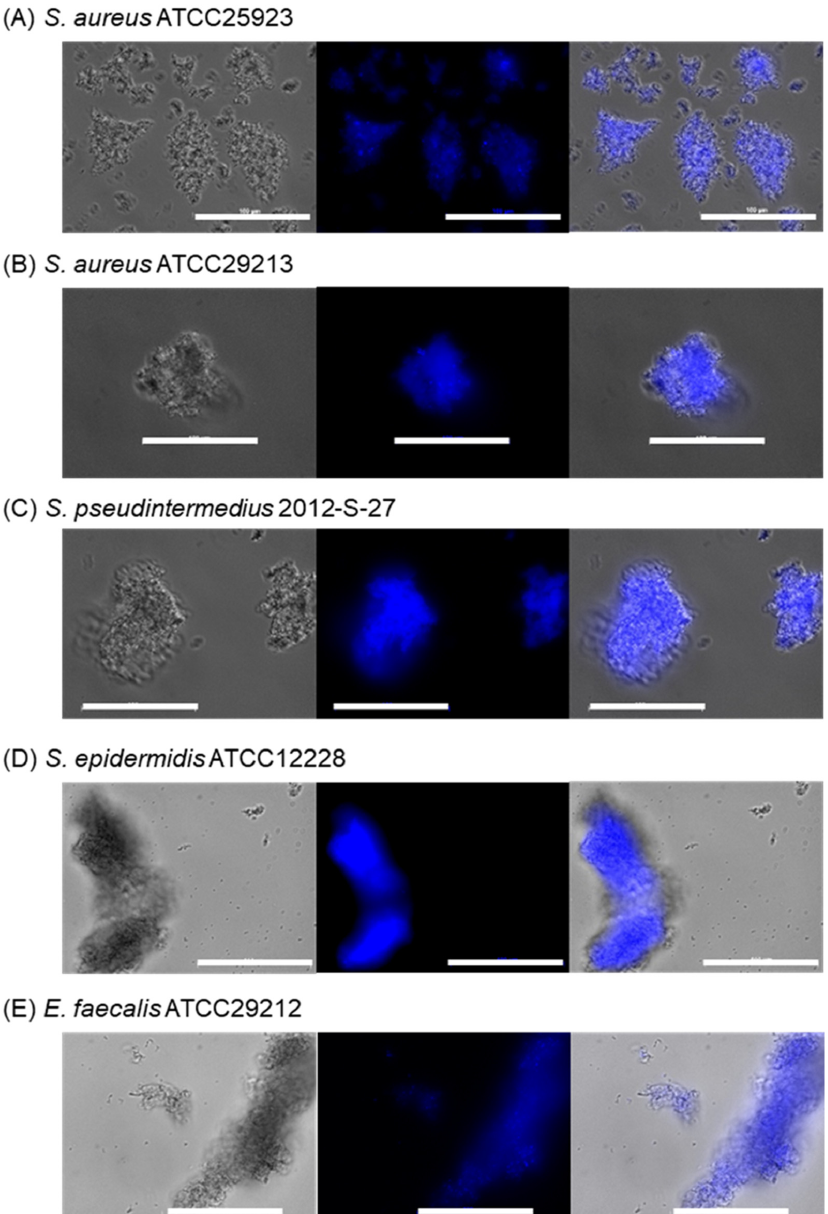
Figure 9. Microscope images of Gram-positive bacteria BenzoB-PAMAM(+) at a pH of 7.4, adjusted with PBS. [BenzoB-PAMAM(+)] = 3.3 × 10 − 6 M; bacterial concentration was set at OD 600 = 0.3. From left to right: DIC, DAPI, and merged microscopy images. Scale bar = 100 µ m. ( A ) S. aureus ATCC25923. ( B ) S. aureus ATCC29213. ( C ) S. pseudintermedius 2012-S-27. ( D ) S. epidermidis ATCC12228. ( E ) E. faecalis ATCC29212.